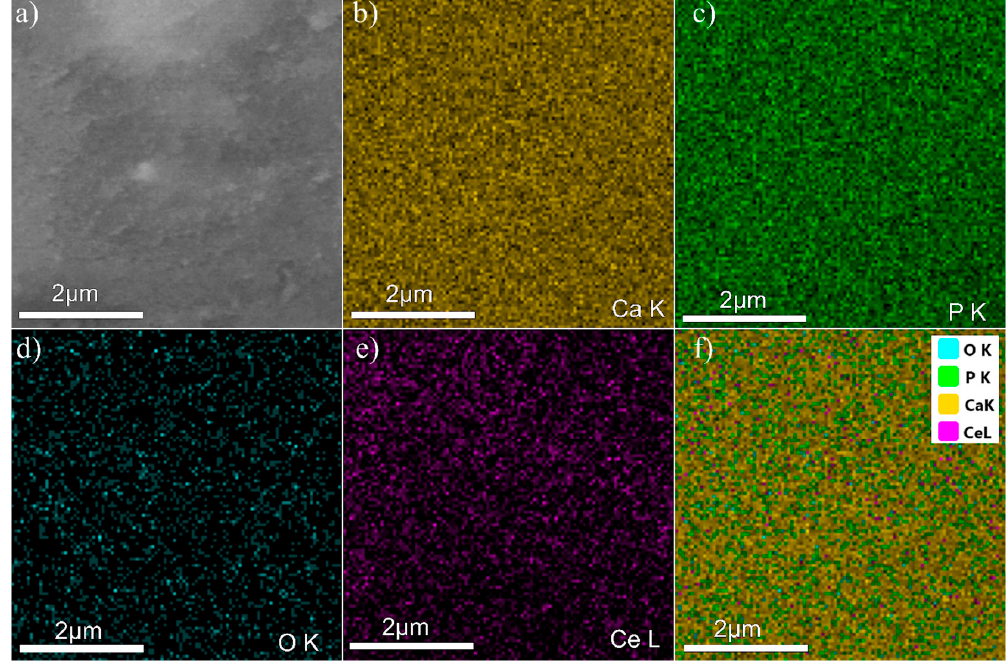
Figure 7. SEM surface morphology images of 5Ce-HAp ( a ). The element mapping of the prepared 5Ce-HAp coating ( b – e ). The overlap of the constituent elements ( f ).